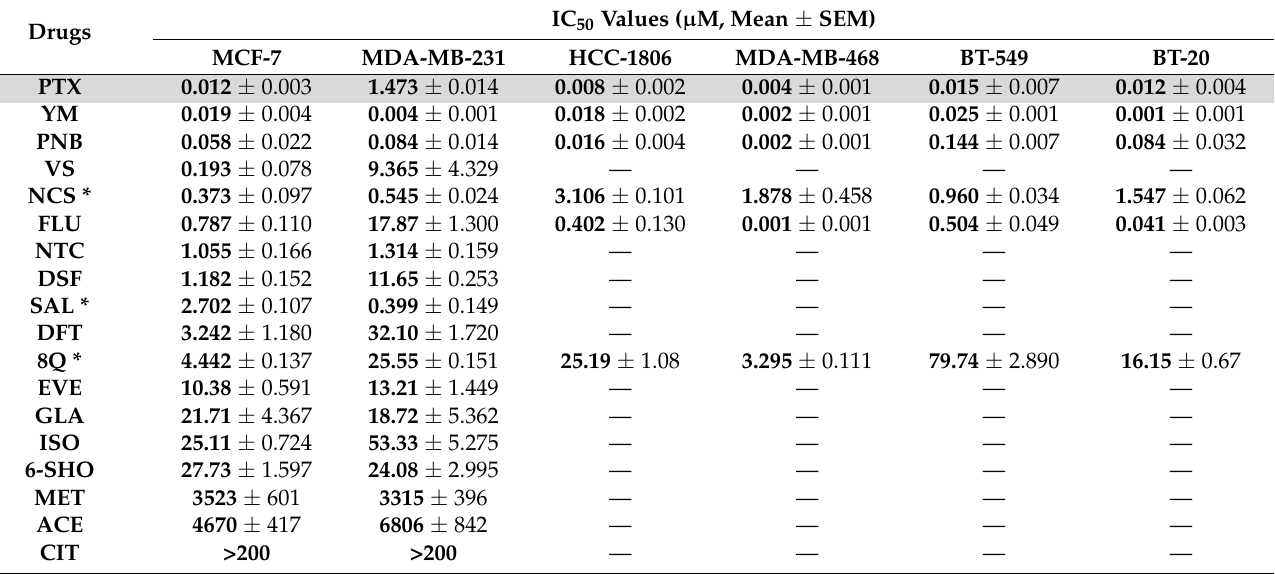
Table 1. Cytotoxic efficacy of selected compounds assessed by MTT assays. IC 50 values of the assessed compounds in the luminal A cell line MCF-7 and TNBC cell lines (mean ± SEM). PTX (in gray) was used as a reference